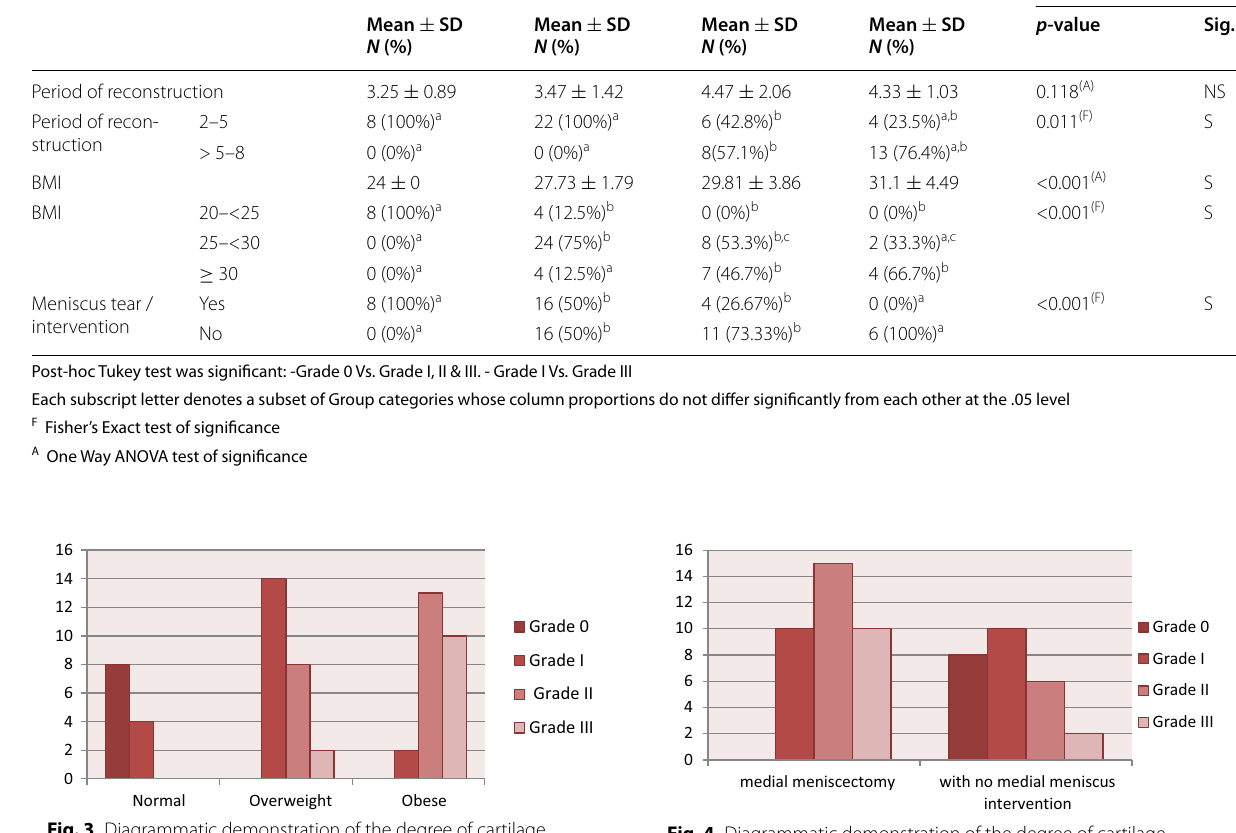
Fig. 4 Diagrammatic demonstration of the degree of cartilage degeneration and history of